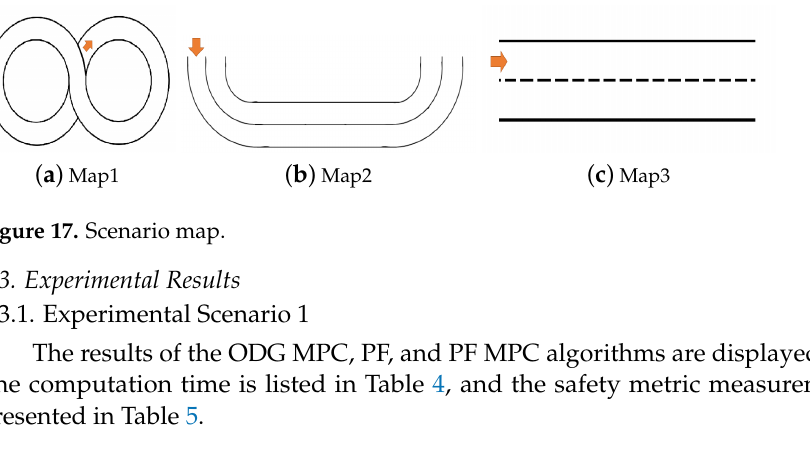
Figure 16. Mobile Robots 1 and 2 on experimental platforms.